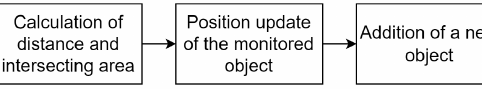
Figure 4. Object